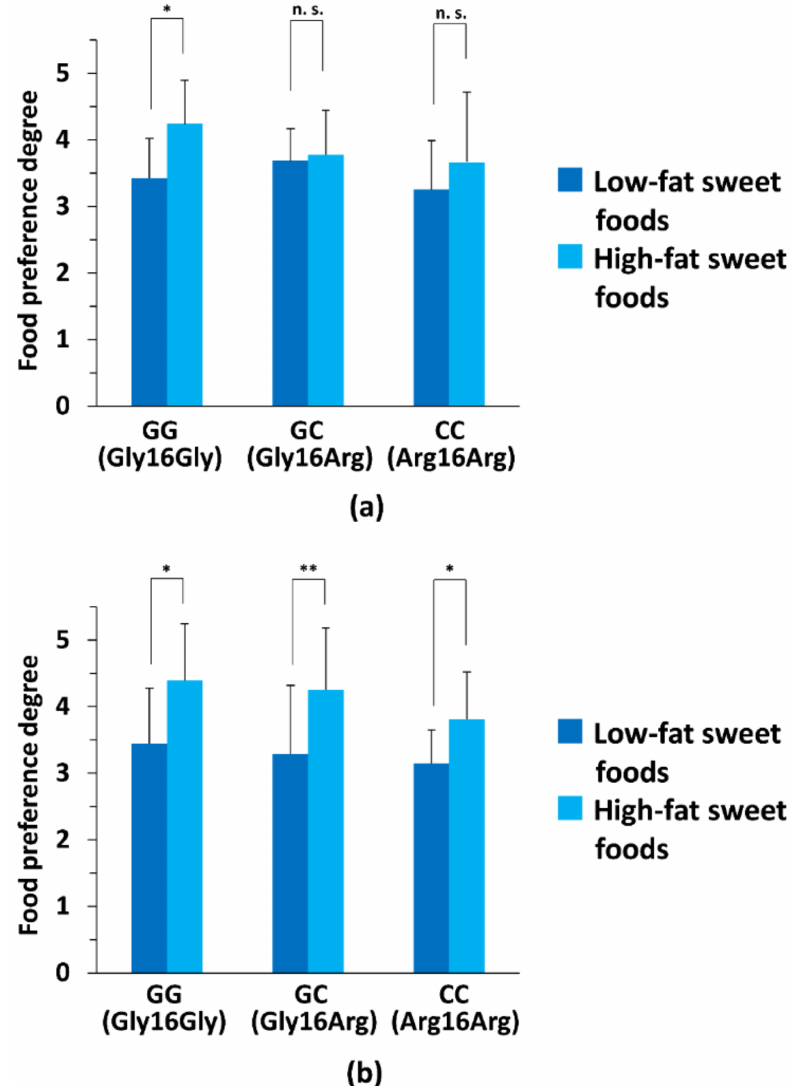
Figure 3. Comparison of the degrees of taste preference between high- and low-fat sweet tastes in each genotype subgroup for male and female subjects. The six sweet foods listed in the self-reporting questionnaire were classified into two subgroups (low-fat sweet foods (yokan, manju, and candy) and high-fat sweet foods (ice cream, chocolate, and strawberry sponge cake)) according to general fat content. ( a ) Comparison of taste preference degrees between low-fat and high-fat sweet tastes in each genotype subgroup for the male subjects. Significant differences were determined between taste preference degrees for low-fat and high-fat sweet foods in each genotype subgroup (subjects with the GG (Gly16Gly) genotype of ADRB2 ( ADRB2 GG subgroup, n = 7), with the GC (Gly16Arg) genotype of ADRB2 ( ADRB2 GC subgroup, n = 15), and with the CC Gly16Arg] genotype of ADRB2 ( ADRB2 CC subgroup, n = 4) of male subjects ( n = 26)). Statistical differences between low-fat and high-fat sweet food groups were determined using a Welch’s t -test. ( b ) Comparison of taste preference extents between low-fat and high-fat sweet tastes in each genotype subgroup for the female subjects. Significant differences were determined between summarized taste preference degrees for low-fat and high-fat sweet foods for each genotype subgroup ( ADRB2 GG subgroup, n = 6; ADRB2 GC subgroup, n = 13; ADRB2 CC subgroup, n = 7) of female subjects ( n = 26). Statistical differences between low-fat and high-fat sweet food groups were determined using a Welch’s t -test. For ( a , b ), * p < 0.05; ** p < 0.01; n.s., not